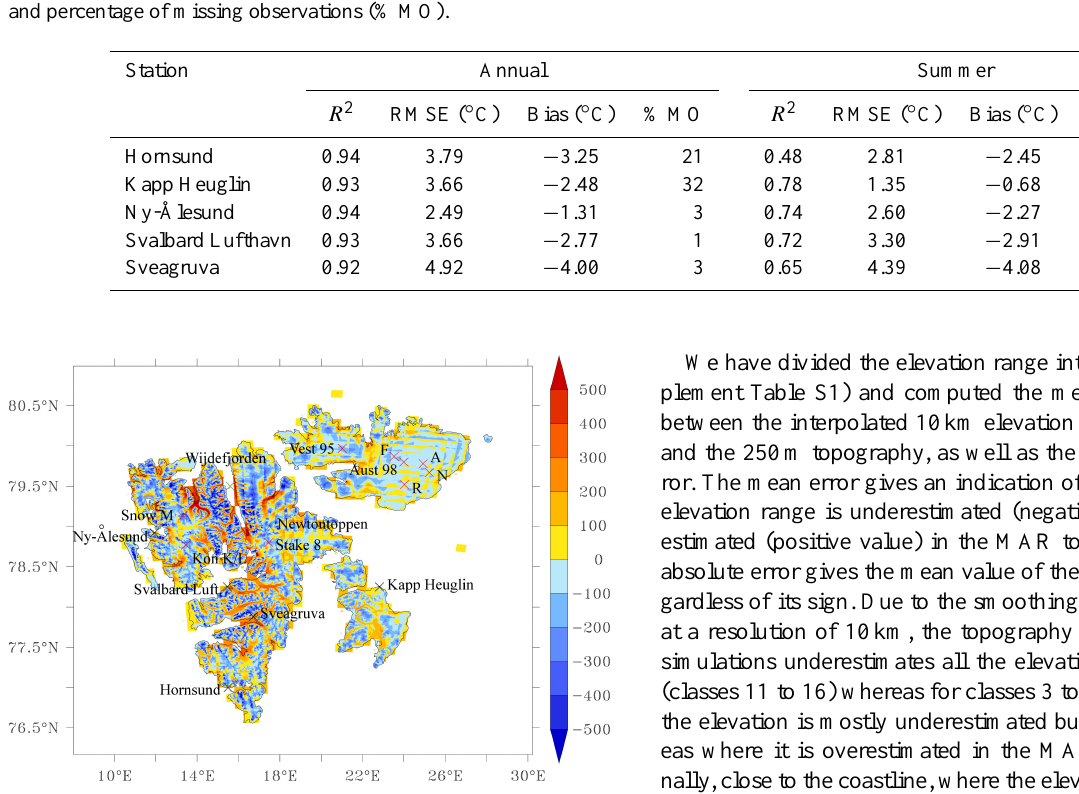
Table 2. 1979–2013 mean annual and summer correlation ( R 2 ), RMSE and bias ( ◦ C) between MAR ERA and the observed daily temperature and percentage of missing observations (% MO).